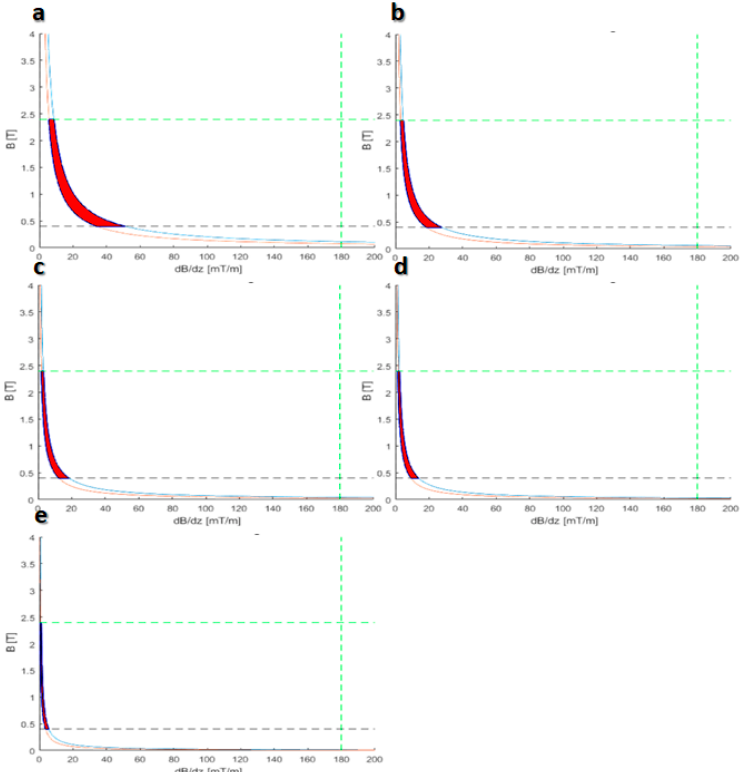
Figure 11. Optimal region for the crossing of functionalized CNT through the cell membrane: ( a ) region